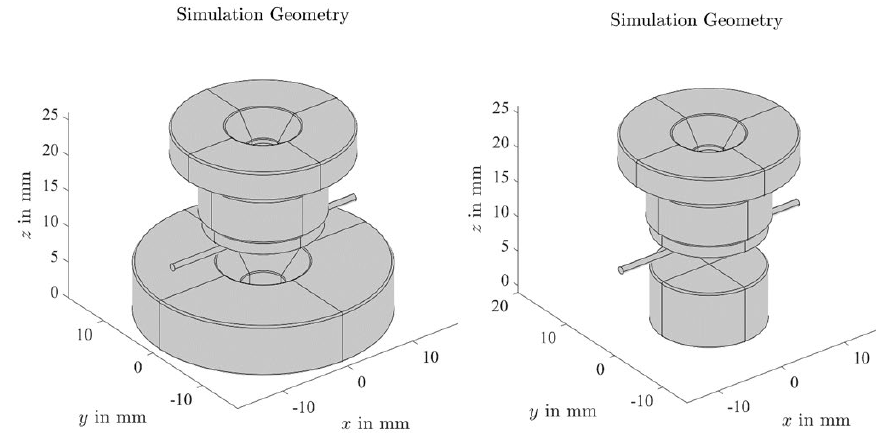
Figure A1. Size distribution of ( A ) Cit-SPIONs, ( B ) Caf-SPIONs, ( C ) SPIONs and ( D ) SPION MTO .